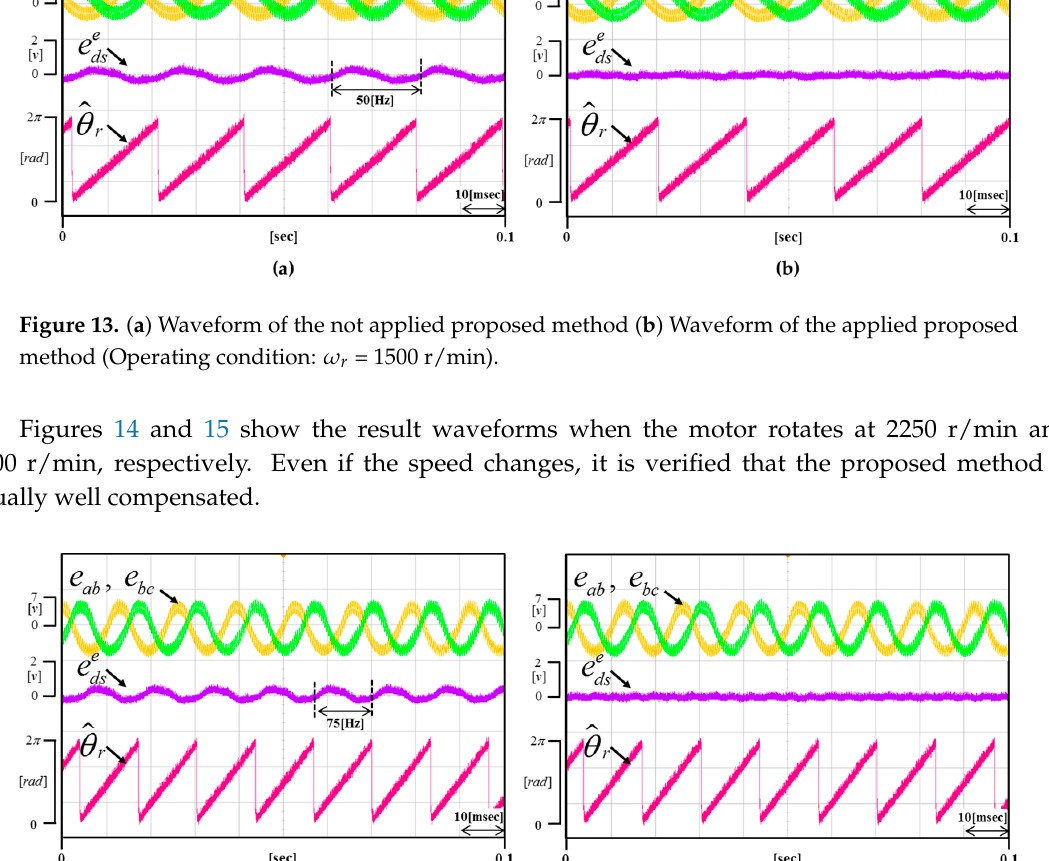
Figure 14. ( a ) Waveform of the not applied proposed method ( b ) Waveform of the applied proposed method (Operating condition: ω r = 2250 r/min).